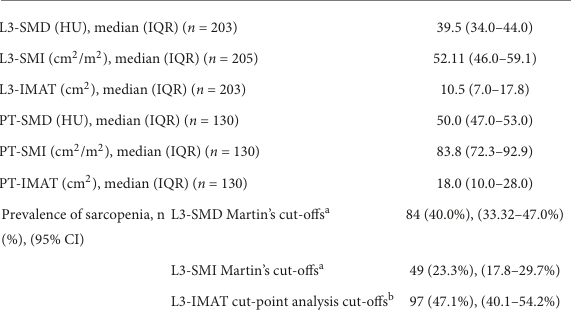
TABLE 2 Distribution of computed tomography (CT) parameters of skeletal muscle quality and quantity, and prevalence of sarcopenia according to different parameters and different cut-off